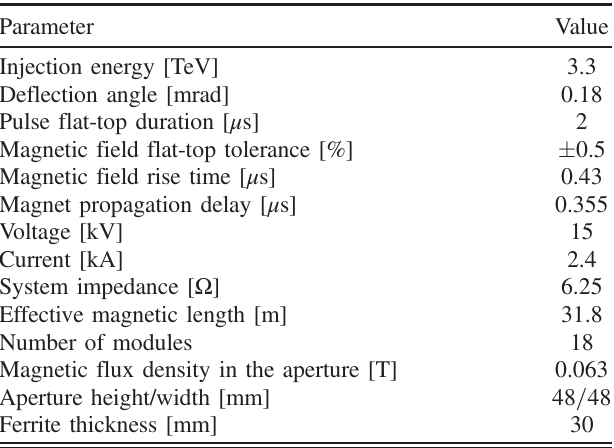
TABLE I. Specifications of the FCC-hh injection kicker sys- tem.